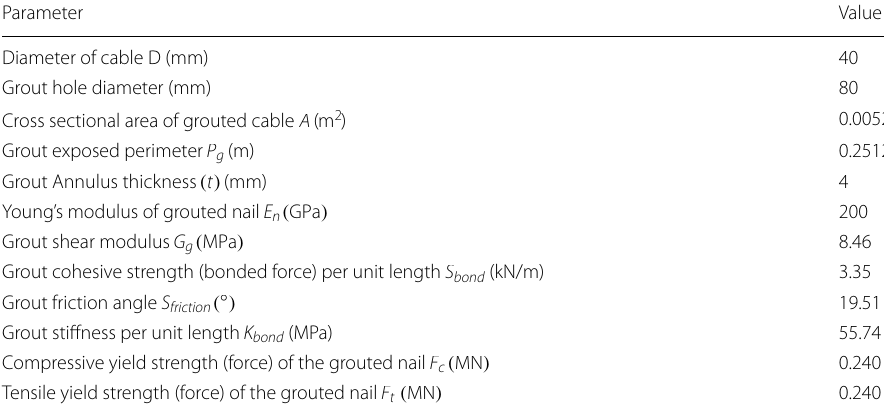
Table 3 Cable parameters design used in 2D FDM modelisation